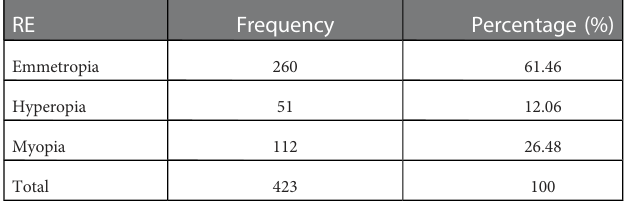
TABLE 4 Bivariable and multivariable logistic regression analysis of factors associated with myopia among pregnant women attending ANC units